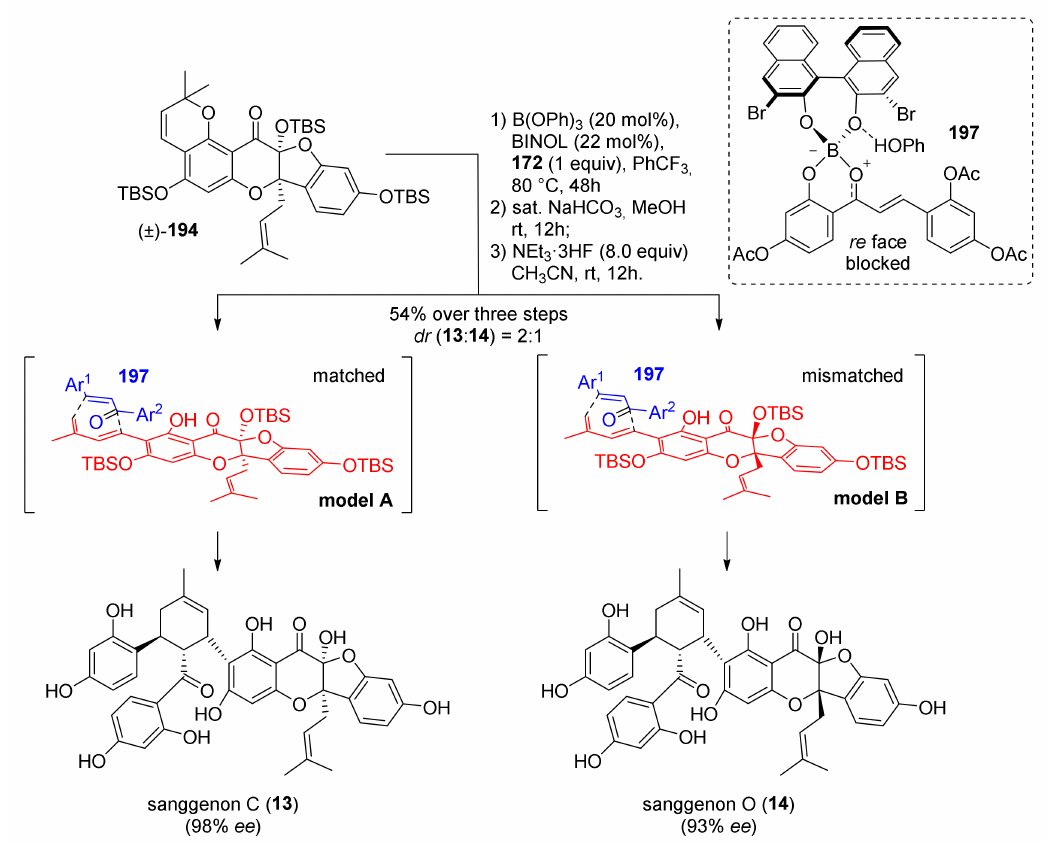
Figure 66. Stereoselective Diels–Alder cycloaddition towards sanggenons C and